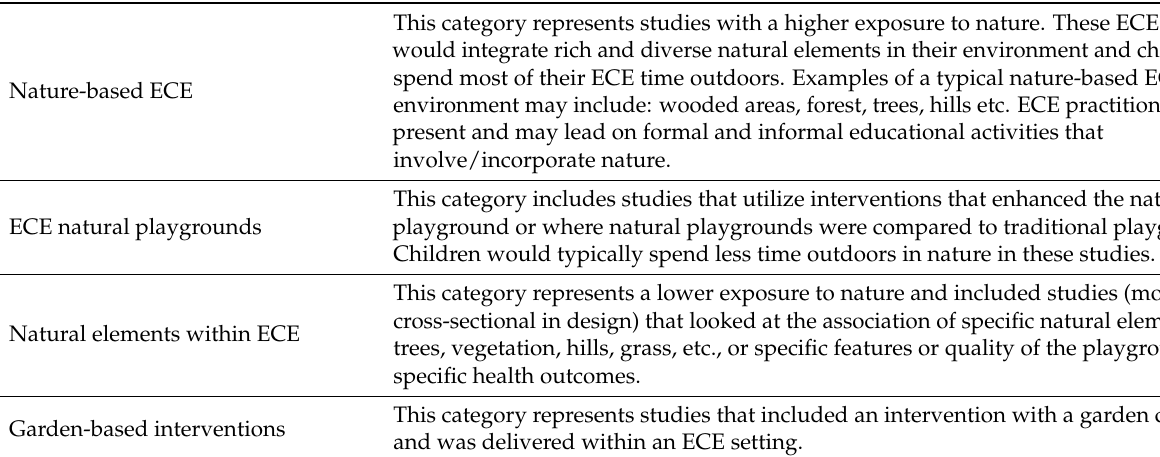
Table 1. Overview of the exposure